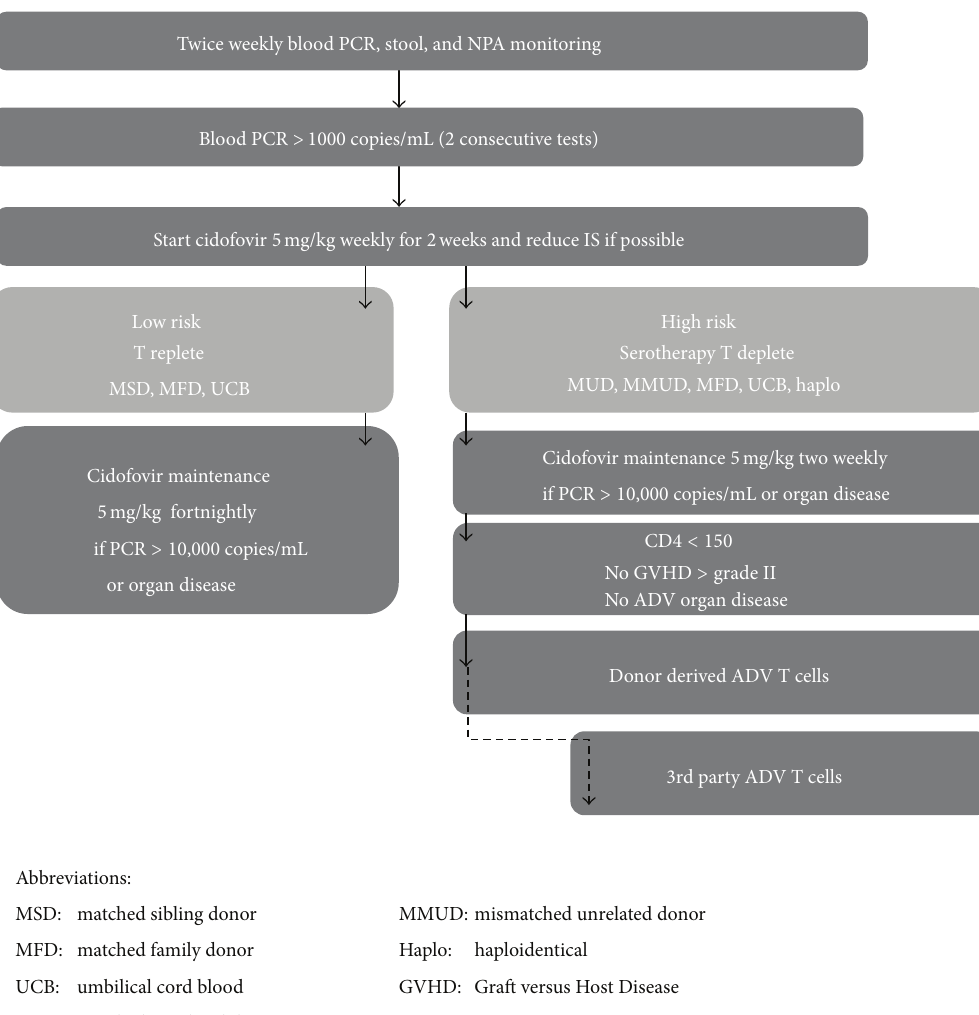
Figure 2: Algorithm for the management of ADV reactivation in children after allogeneic stem cell